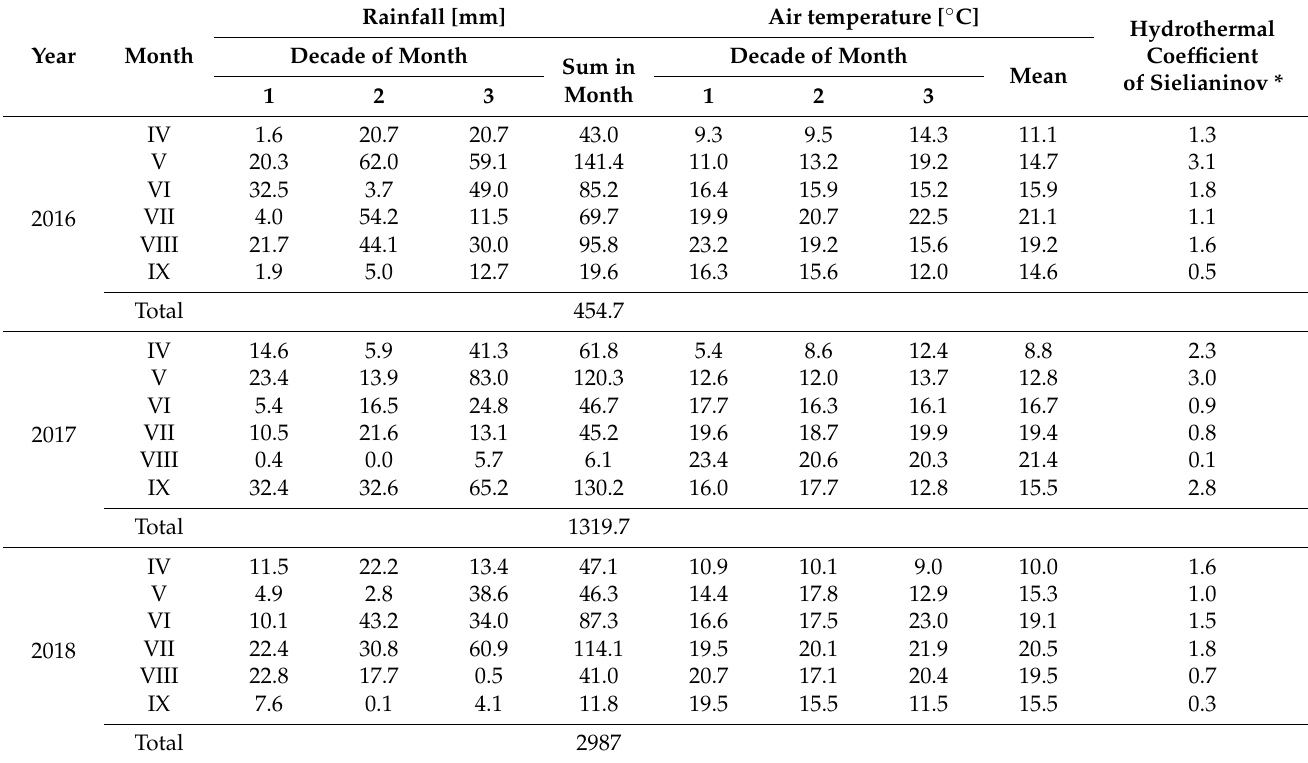
Table 3. Rainfall, air temperature and the hydrothermal of coefficient of Sielianinov, during the growing season of potato, according to the meteorological station in Uhnin